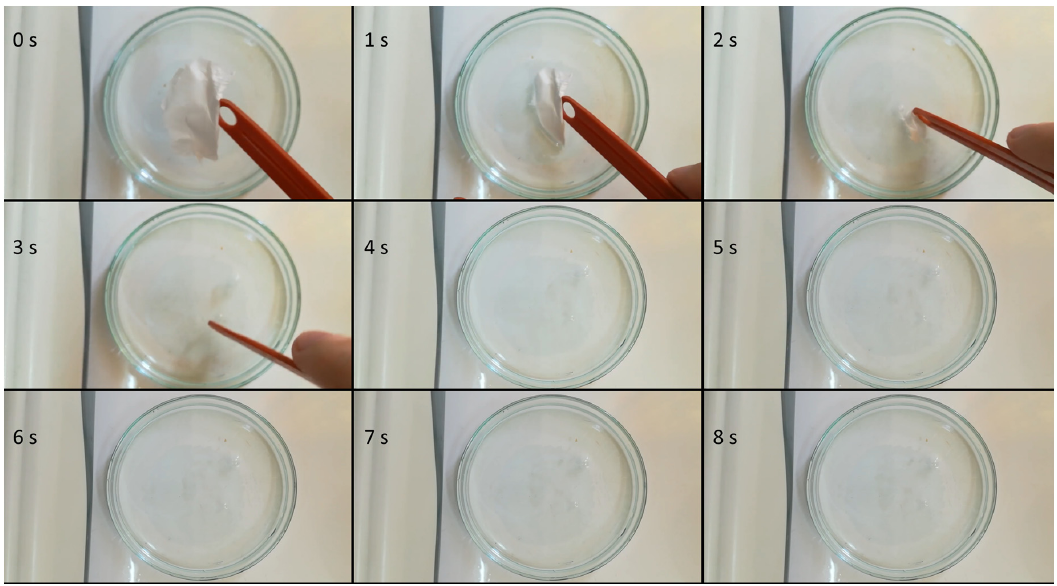
Figure 3. Sequential photographs of the disintegration process of the obtained microfibrous mesh.